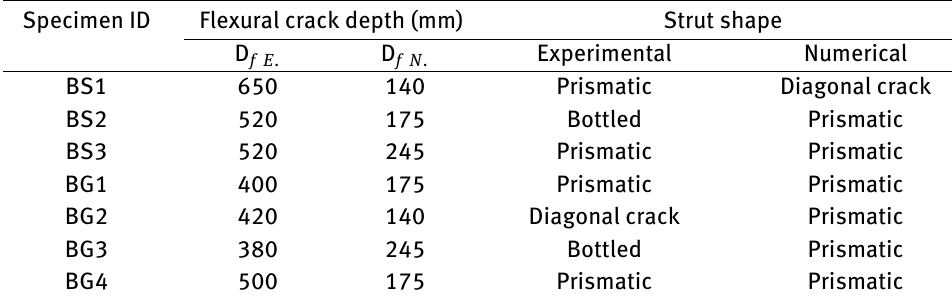
Table 14: Summary of experimental and numerical results Specimen ID